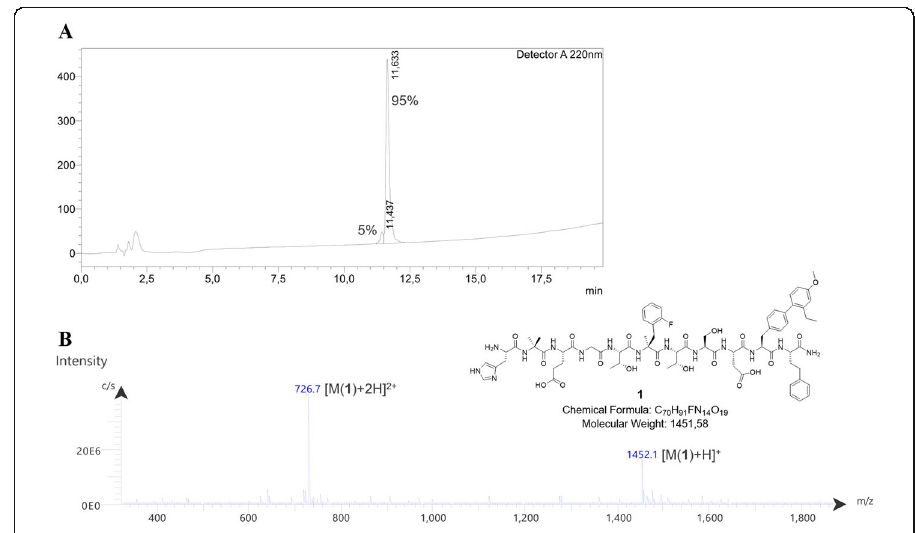
Fig. 2 A HPLC chromatogram of purified lead peptide 1 (20 – 80% B in 15 min, Method A*, 1 mL/min, t R = 11.6 min), which was obtained in 95% chemical purity. B Corresponding mass spectrum of the HPLC- fraction collected at 11.6 min. *Method A: solvent A = water + 0.1% TFA, solvent B = acetonitrile + 2% water + 0.1%